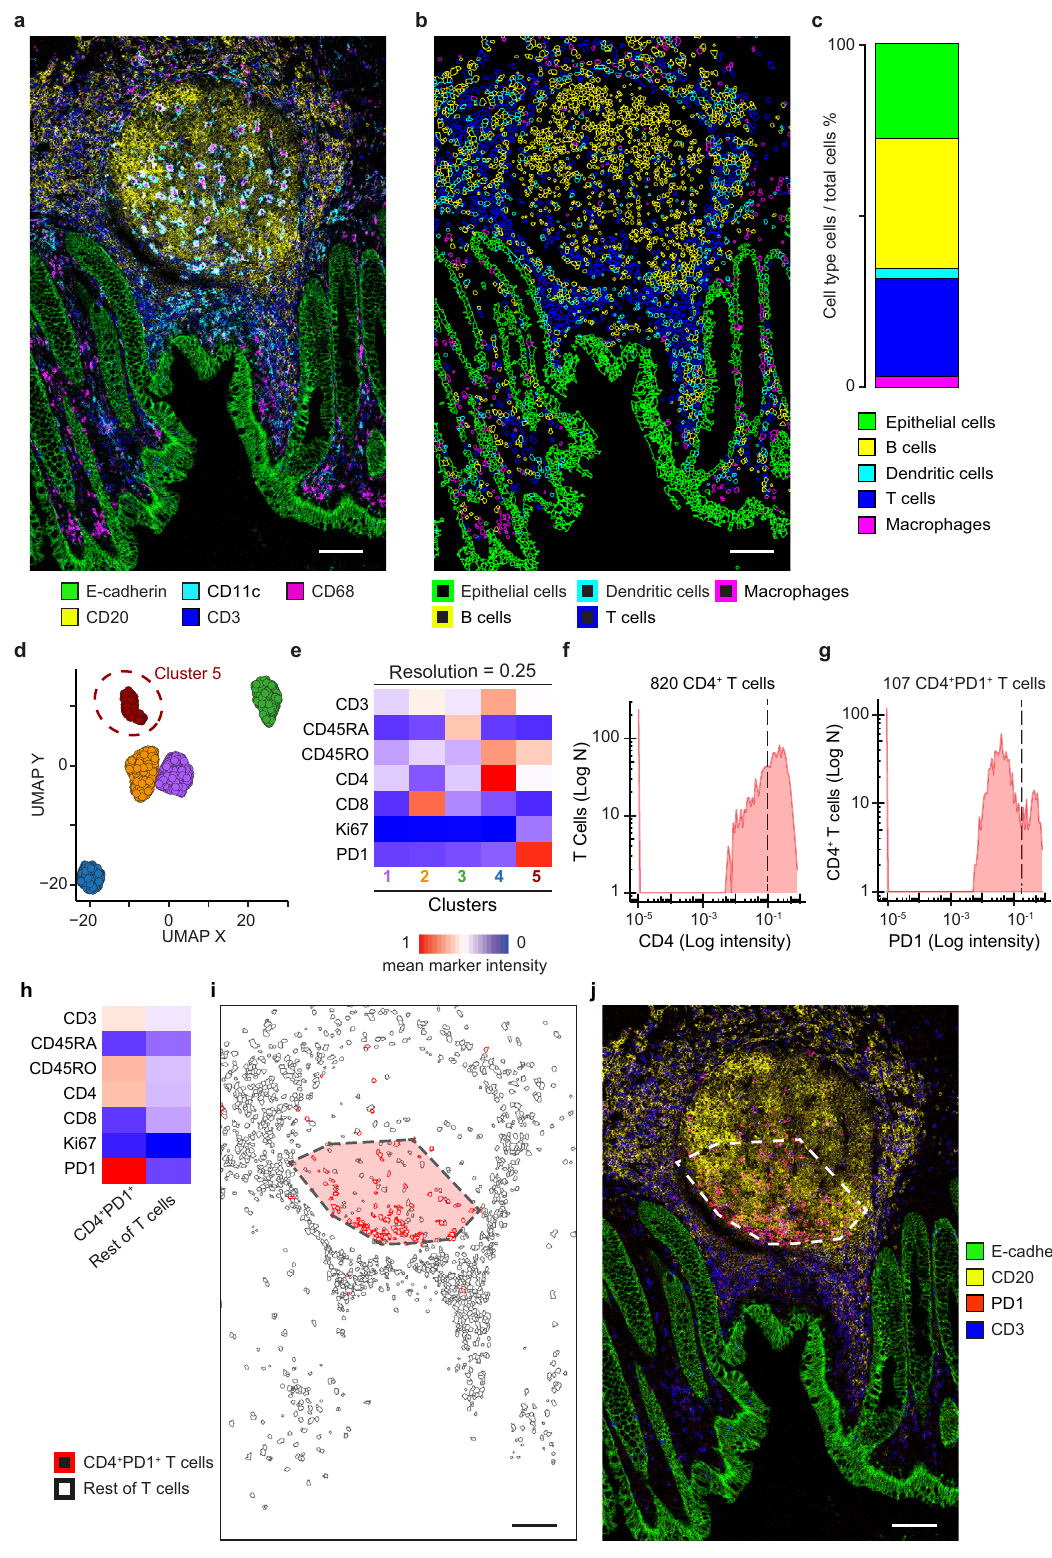
endothelial cells in Crohn ’ s-like reaction (CLR) and diffuse in fl ammatory in fi ltration (DII) colorectal cancer subtypes 9 . The high-dimensional imaging data were derived from 35 colorectal cancer samples (17 CLRs and 18 DIIs, Supplementary Data 1) and were obtained using CODEX with a 56 marker panel 9